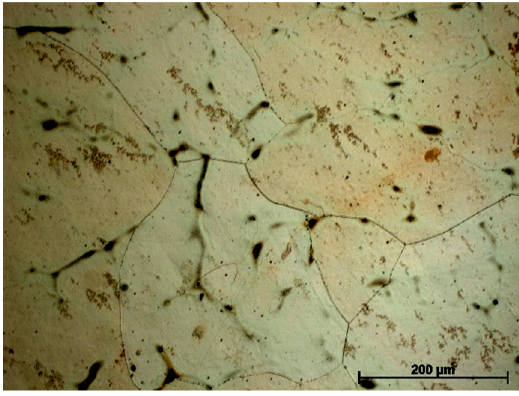
Figure 5. Microstructure of Cu–2Ni–1Si–0.6Re, initial state. Cooling rate 1.5 °C s − 1 .